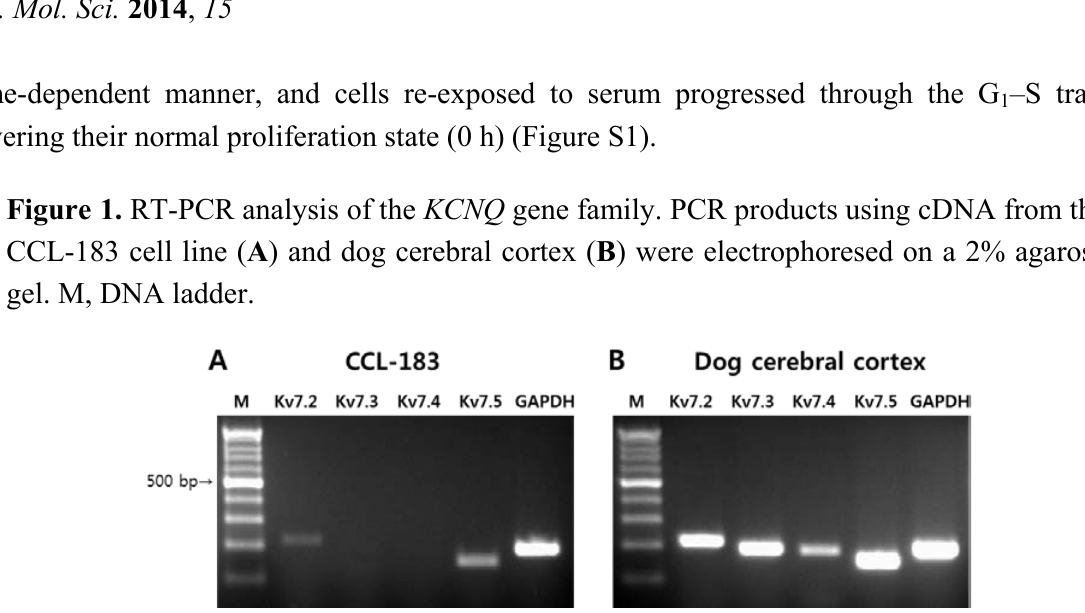
Figure 2. Upregulation of Kv7.5 expression levels by serum deprivation. ( A ) The cells were seeded onto plates and incubated overnight before serum withdrawal. On the following day, one plate of cells was harvested as a control for the experiments (0 h), and the other subconfluent proliferating cells were washed two times with warm PBS and transferred into serum-free DMEM. The cells were further incubated for 6, 10, 20, 30, 44, 54, and 68 h (prefixed with “−” to imply the withdrawal of serum) and harvested. Three plates of cells were transferred into complete growth medium after 30 h of serum deprivation to –S transition and incubated for 14, 24, and 38 h induce the cell progression into the G 1 (prefixed with “+” to imply the re-addition of serum); The relative expression levels of Kv7.5 in the presence or absence of FBS were analyzed by qPCR ( B ) and western blot analysis ( C ). The values are the mean ± SEM of five ( B ) and four ( C ) independent experiments. The asterisks denote values significantly different from the control (0 h). * p < 0.05; ** p <